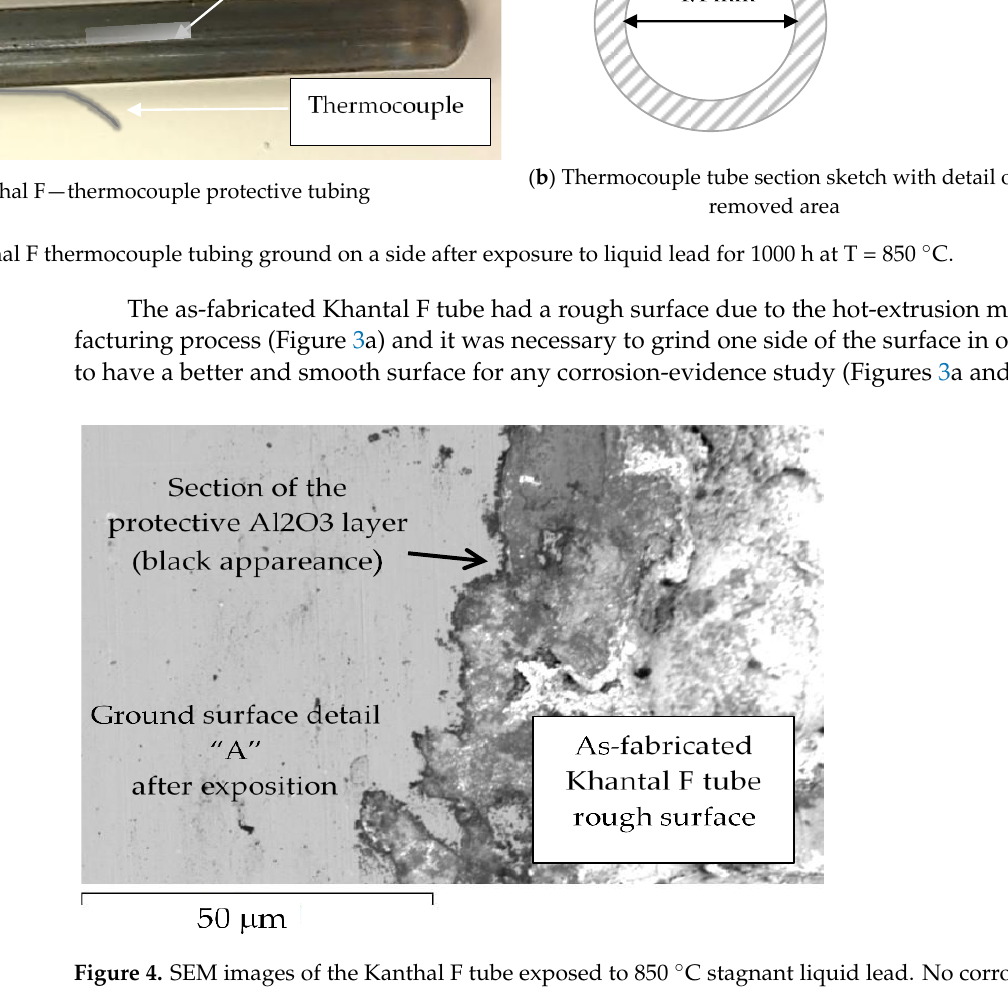
Figure 4. SEM images of the Kanthal F tube exposed to 850 ◦ C stagnant liquid lead. No corrosion attacks were observed across the analyzed ground surface zone, “detail A”. The arrows point to a dark line at the metal–oxide interface, indicating formation of a protective alumina scale. The rough surface is not due to corrosion, but is due to the as-fabricated hot extrusion process.